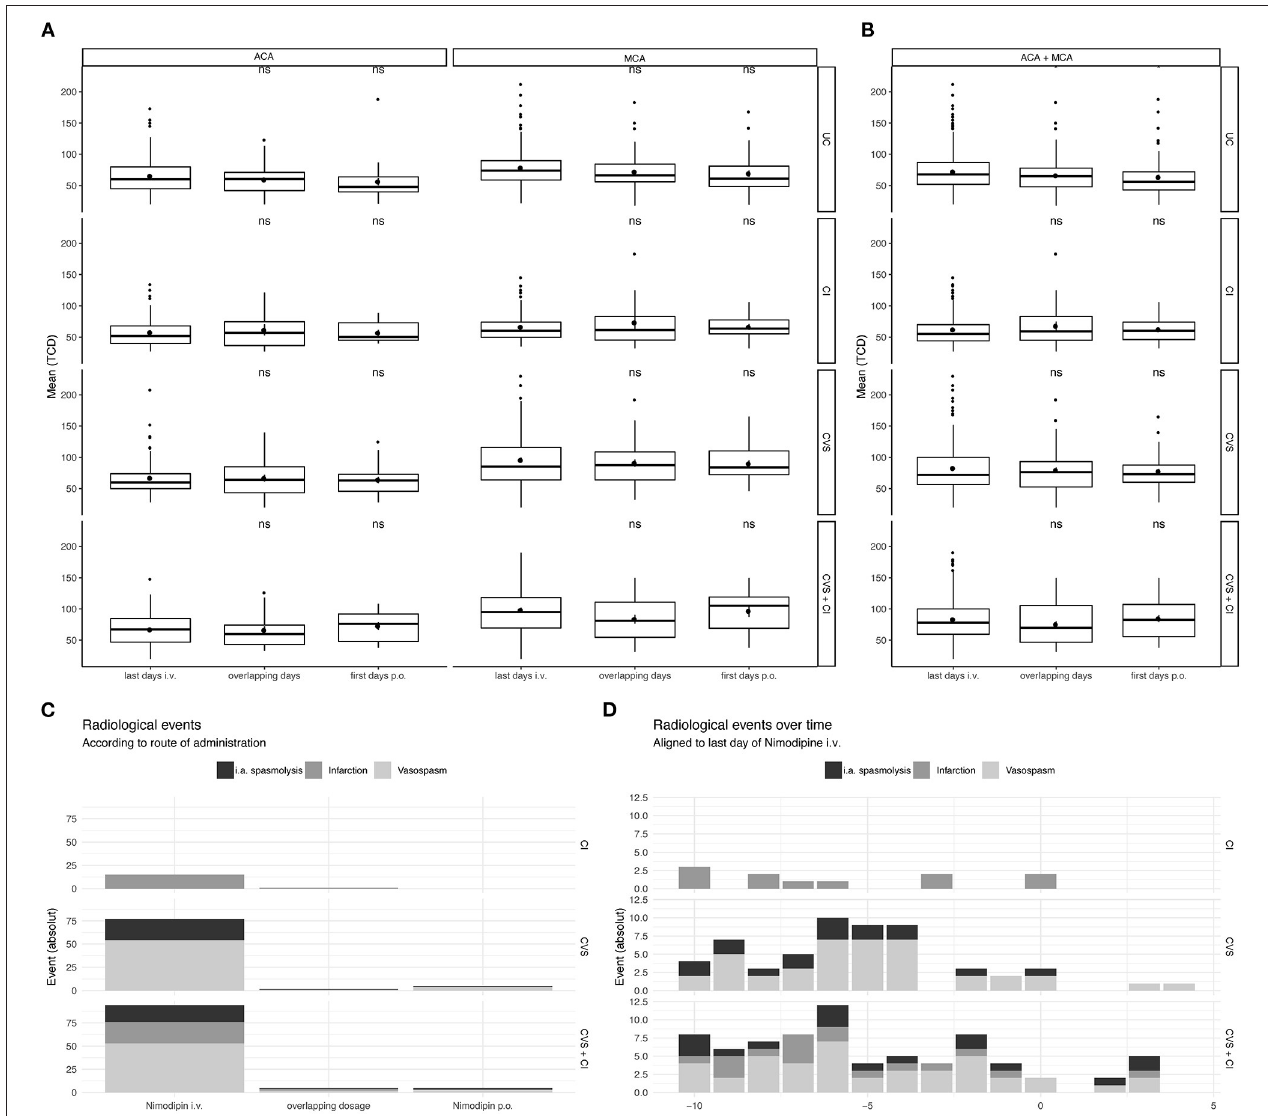
FIGURE 4 | Temporal resolution of complications in subgroups in relation to the timing of the switch. Taking all measured TCD values in account of all patients included in the study not only longitudinal but all values were considered. TCD values on the last 2 days of Nimodipine iv. and the first 2 days of oral administration only were depicted, together with overlapping dosages. Grouping is done according to radiological findings: Uncomplicated Course (UC), Cerebral Infarction (CI), Cerebral Vasospasms (CVS), and Cerebral Vasospasm and Cerebral Infarctions (CVS + CI). (A) Values for A. cerebri anterior (upper) and A. cerebri media (lower) are depicted separately. (B) All TCD values independent of their circulation are depicted. The lower and upper hinges of the boxplots correspond to the first and third quartile of all values. The whiskers represent the 1.5 inter quantile range (IQR). Statistical analysis was performed with unpaired t -test compared to the last day of i.v. administration. (C) Absolute amount of the radiological events are show according to the administered drug. (D) Radiological events over all the ICU stay (Absolute numbers). ns, not